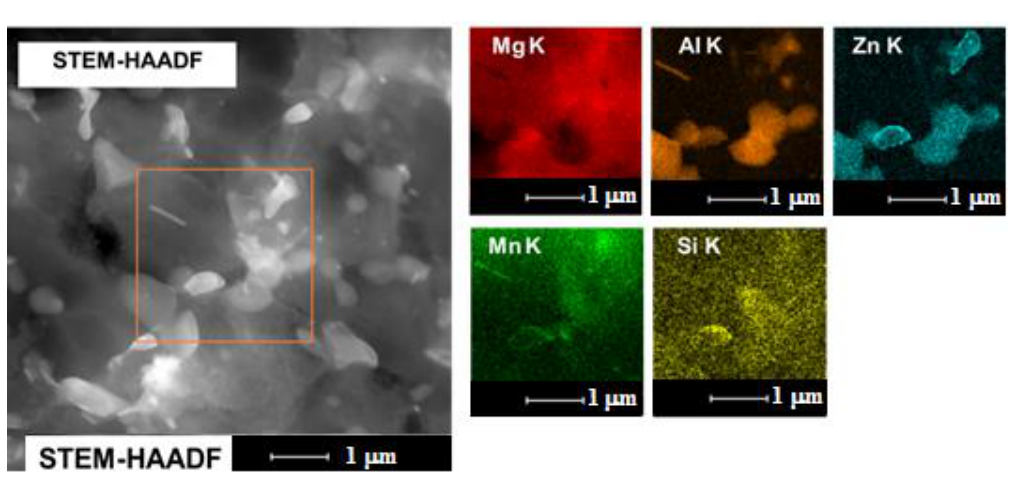
Figure 12. STEM-HAADF image and corresponding elemental maps performed at the marked area of the sample after the third pass.